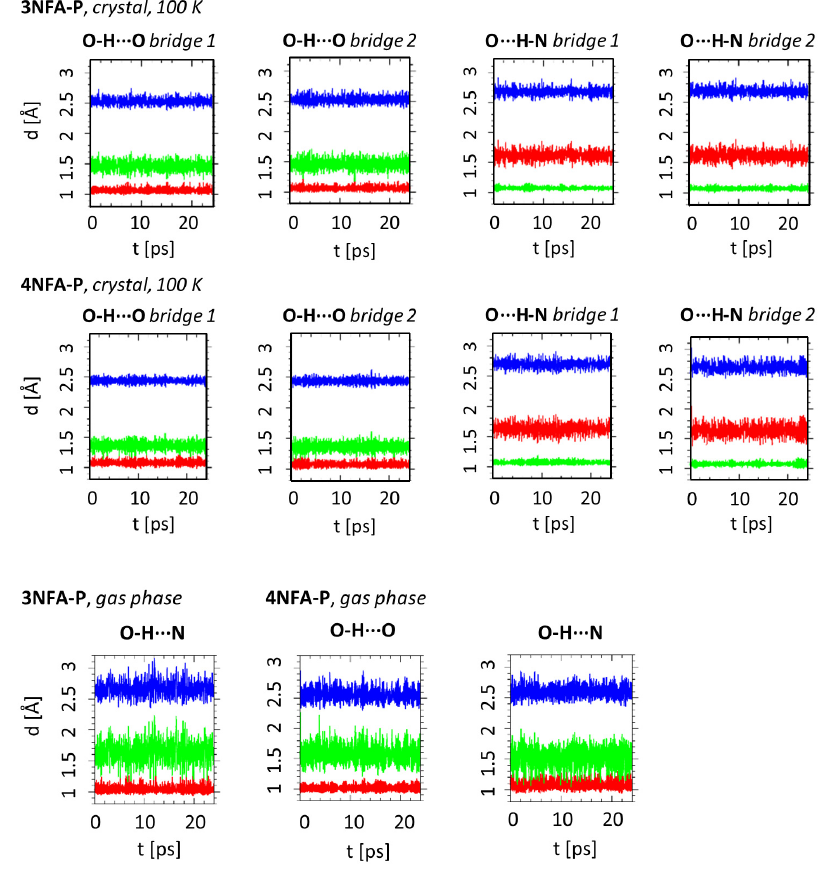
Figure A3. Time-evolution of metric parameters of the OHO and OHN hydrogen bonds–results of Figure A3. Time ‐ evolution of metric parameters of the OHO and OHN hydrogen bonds–results of CPMD simulations in gas phase and the solid state (100 K) of the 3NFA ‐ P and 4NFA ‐ P complexes. CPMD simulations in gas phase and the solid state (100 K) of the 3NFA-P and 4NFA-P complexes. The colors used in the graphs denote respectively: red–donor ‐ proton distance, green–proton ‐ accep ‐ The colors used in the graphs denote respectively: red–donor-proton distance, green–proton-acceptor tor distance, blue–donor ‐ acceptor distance. distance, blue–donor-acceptor